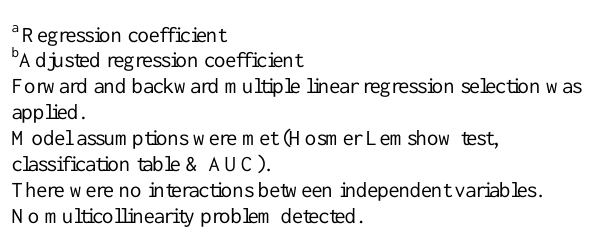
Table 1: Multiple logistic regression analysis for disability